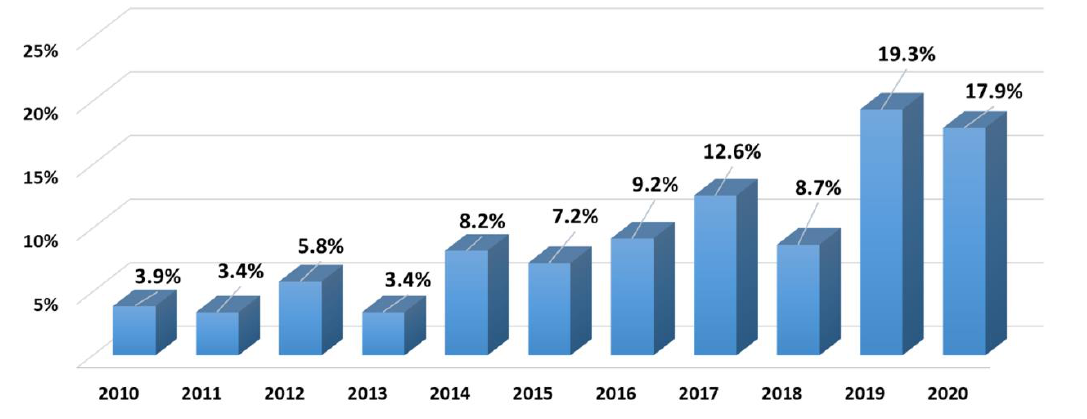
Figure 5. Number of published documents related to pulsed laser welding.